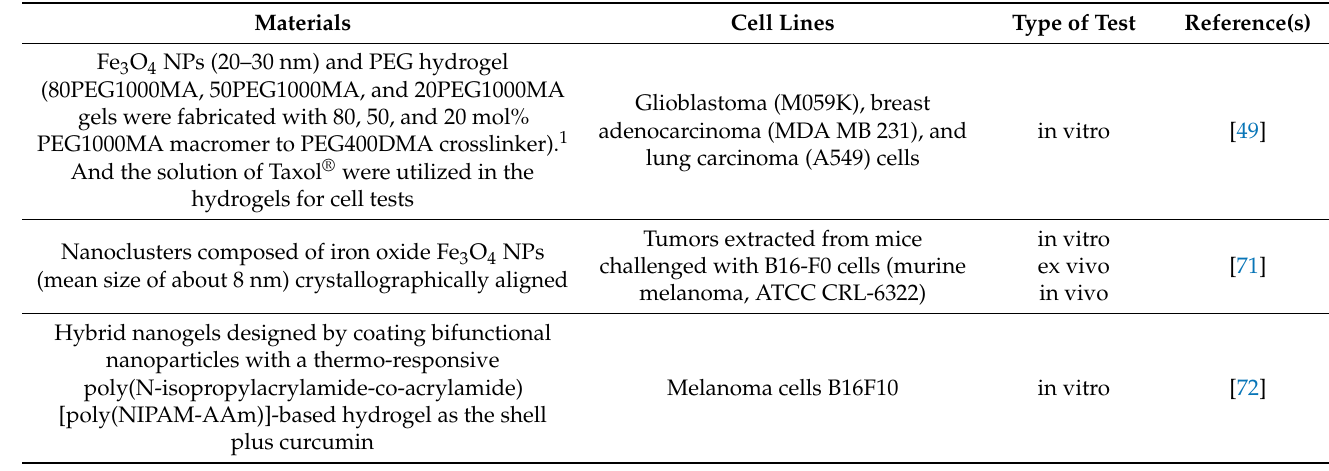
Table 1. Summary of other studies that developed magnetic nanocomposites using iron oxides, test types and cell